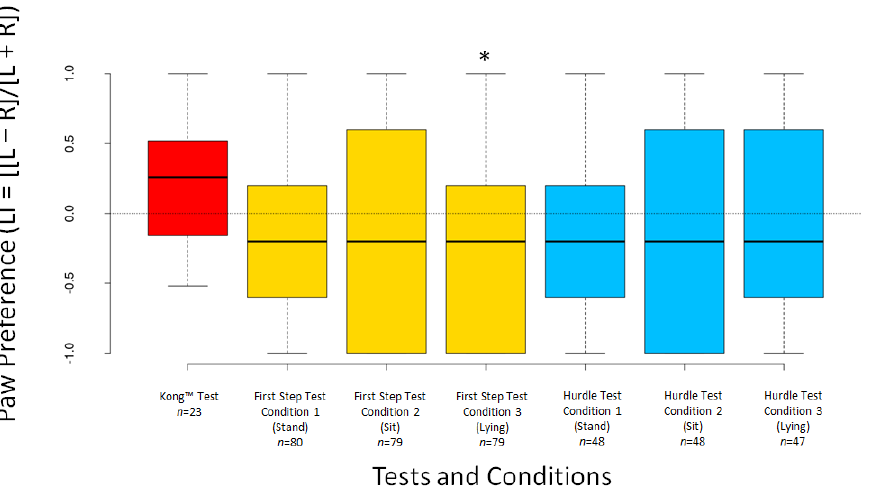
Figure 5. Boxplots showing dogs’ LI scores in the different tests and conditions. Asterisks indicate significant deviations from 0 (* p < 0.05).